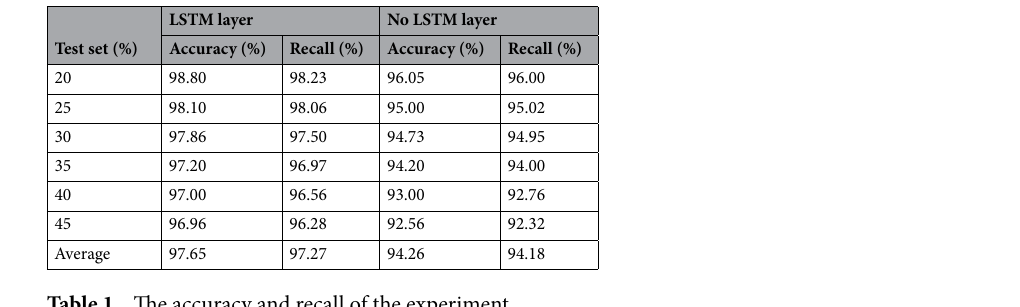
Table 1. The accuracy and recall of the experiment.